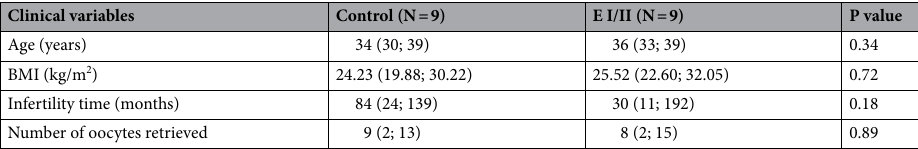
Table 1. Clinical variables of women with endometriosis I/II and controls. Data presented as median (minimum and maximum). E I/II, minimal and mild endometriosis; BMI, Body Mass Index. p value < 0.05.